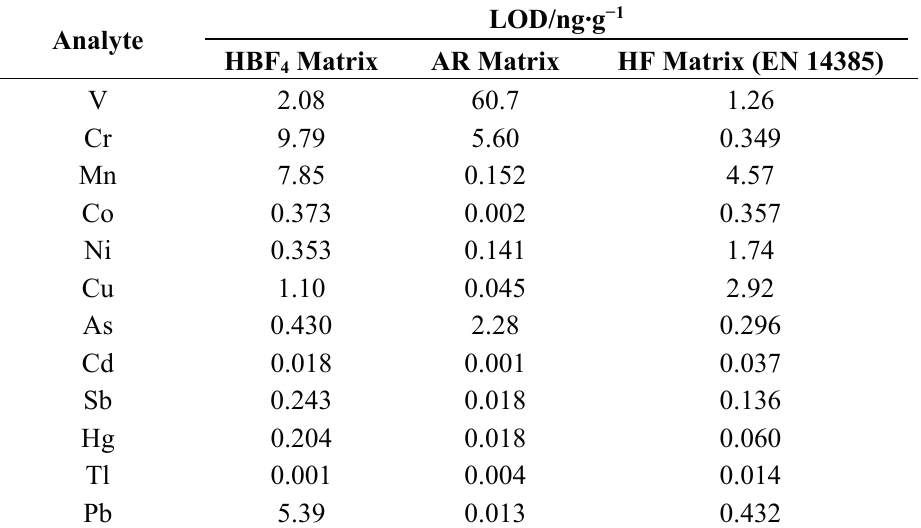
Table 3. Comparison of LODs obtained with both preparation methods.